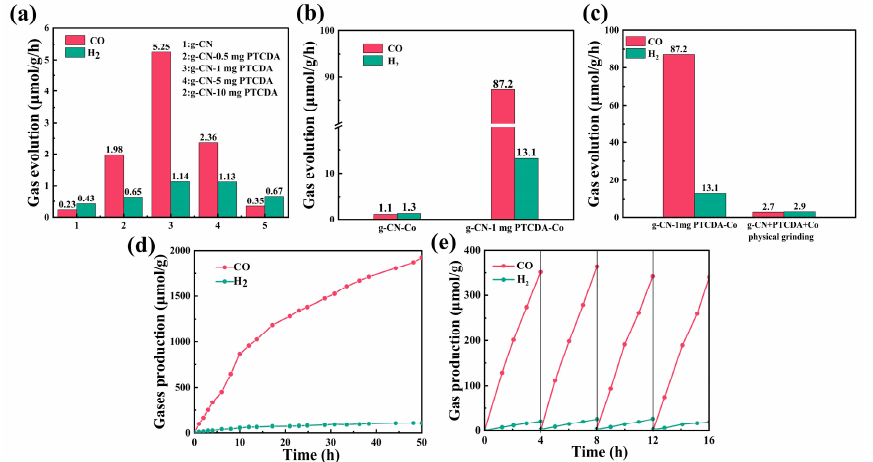
Figure 5. The effects of different PTCDA contents on the evolution of CO and H 2 ( a ), g-CN-Co and g-CN-1 mg PTCDA-Co gases production rate ( b ), comparison of CO and H 2 evolution rates of the covalent bond connection and physical mixing of g-CN and PTCDA ( c ), CO 2 reduction stability of g-CN-1 mg PTCDA-Co under 50 h light condition ( d ), the yields of CO and H 2 under the catalytic action of g-CN-1 mg PTCDA-Co over four continuous cycles and each cycle lasted 4 h ( e ). Afterward, the photocatalyst g-CN-1 mg PTCDA-Co was fabricated by hydrothermal